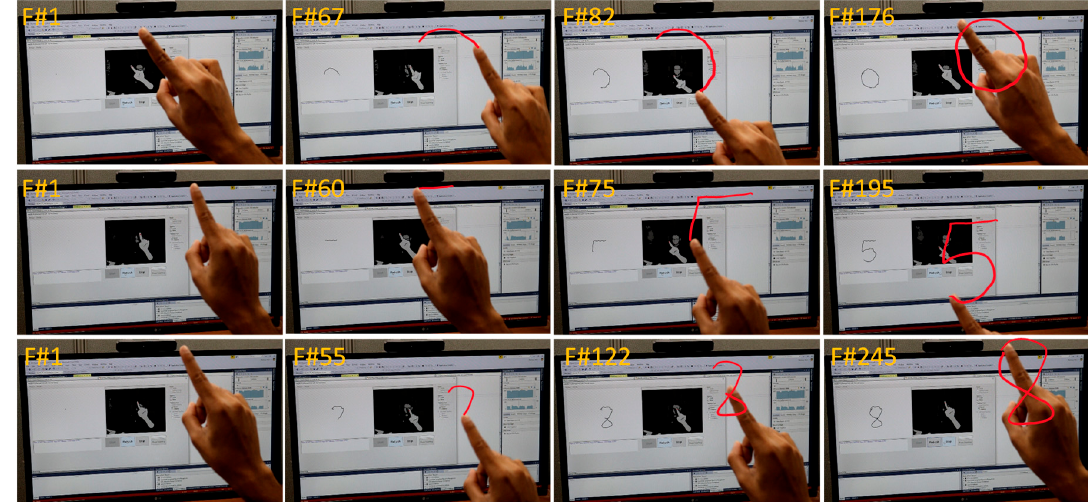
Figure 9. Sample digit writing order, frame by frame representation of digits 0, 5, and 8.